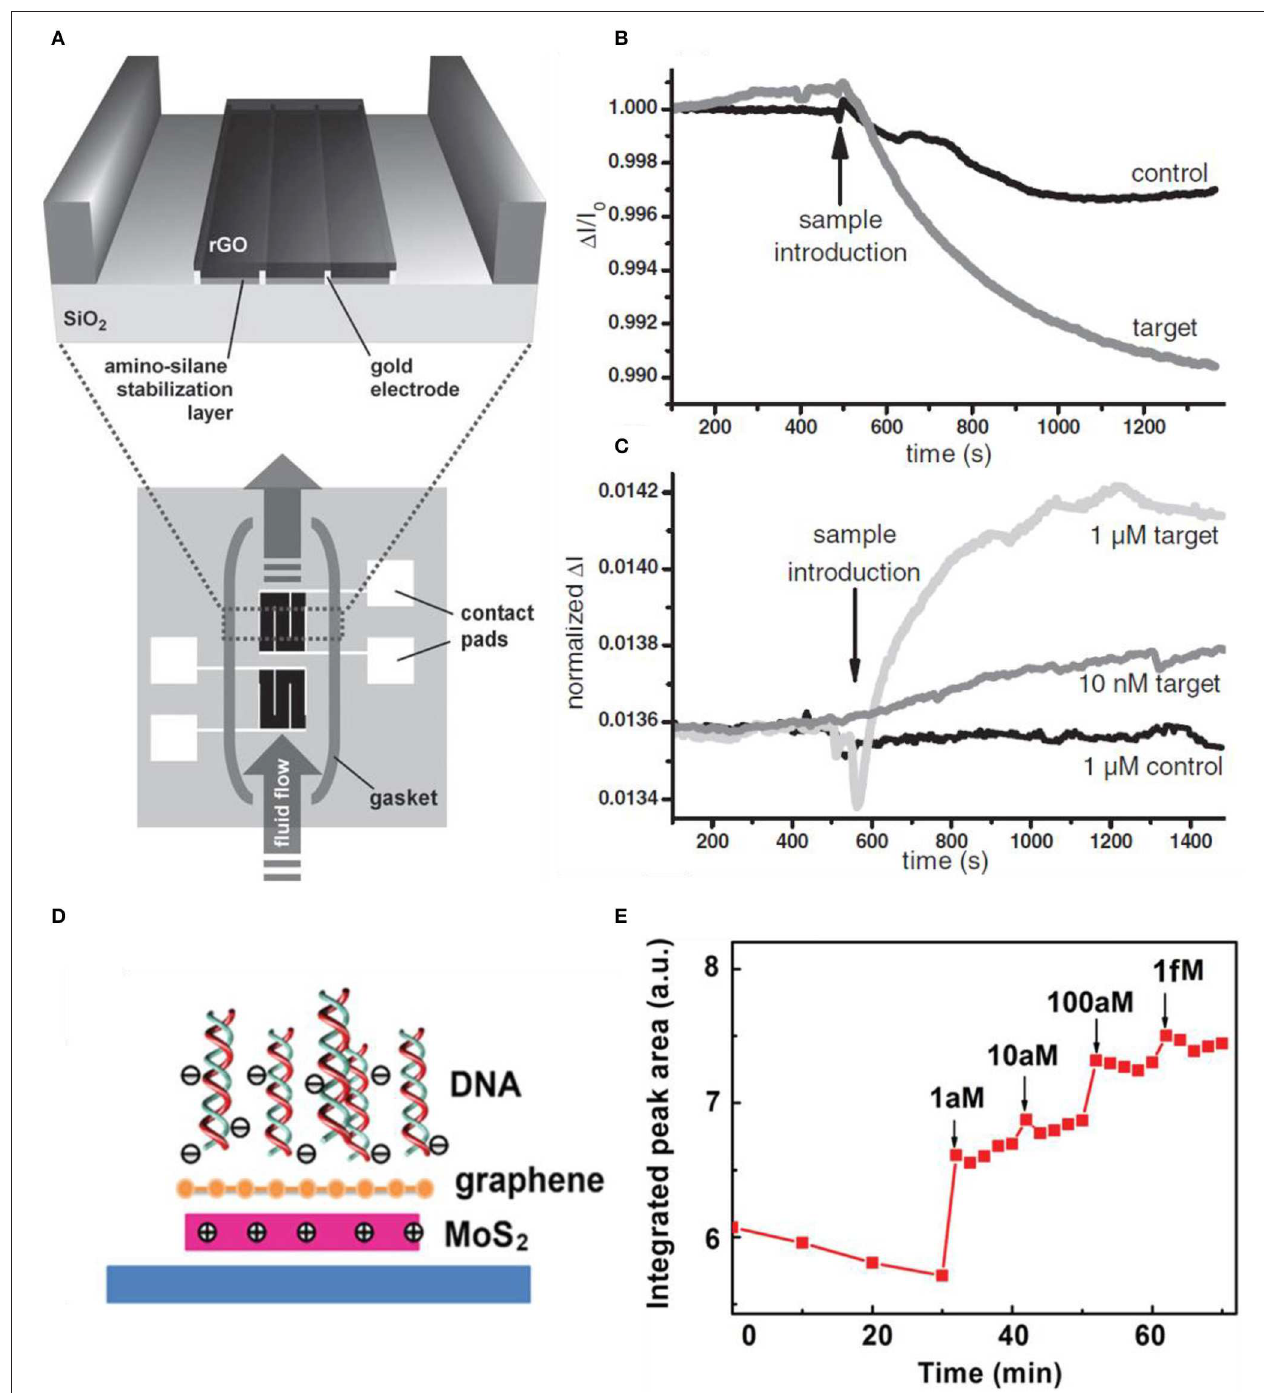
FIGURE 10 | RGO FET for real-time DNA detection. (A) Schematic diagram of RGO FET. RGO is deposited on top of the pre-fabricated electrodes. The two devices are isolated, to eliminate non-specific biological adhesion (bottom), which acts as a reference device. (B) RGO FET sensing curves toward DNA. Non-specific binding (control curve) occurs to the first device (bottom device in (A) . (C) Second device curves having much more selectivity toward the target DNA. Figures (A–C) were reproduced from Stine et al. (2010) with permission from Wiley. Graphene/MoS 2 heterostructures for detection of DNA. (D) Scheme of the charge distribution when DNA becomes adjacent. (E) Photoluminescence response of graphene/MoS 2 to increased concentration of the target DNA. Figures (D,E) were reproduced from Loan et al. (2014) with permission from Wiley.